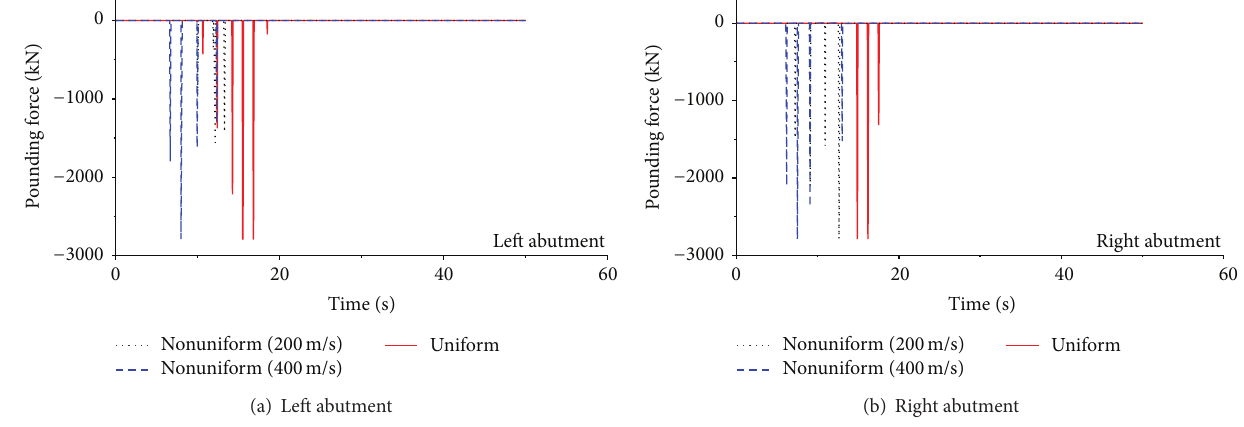
Figure 9: Time history of pounding force at